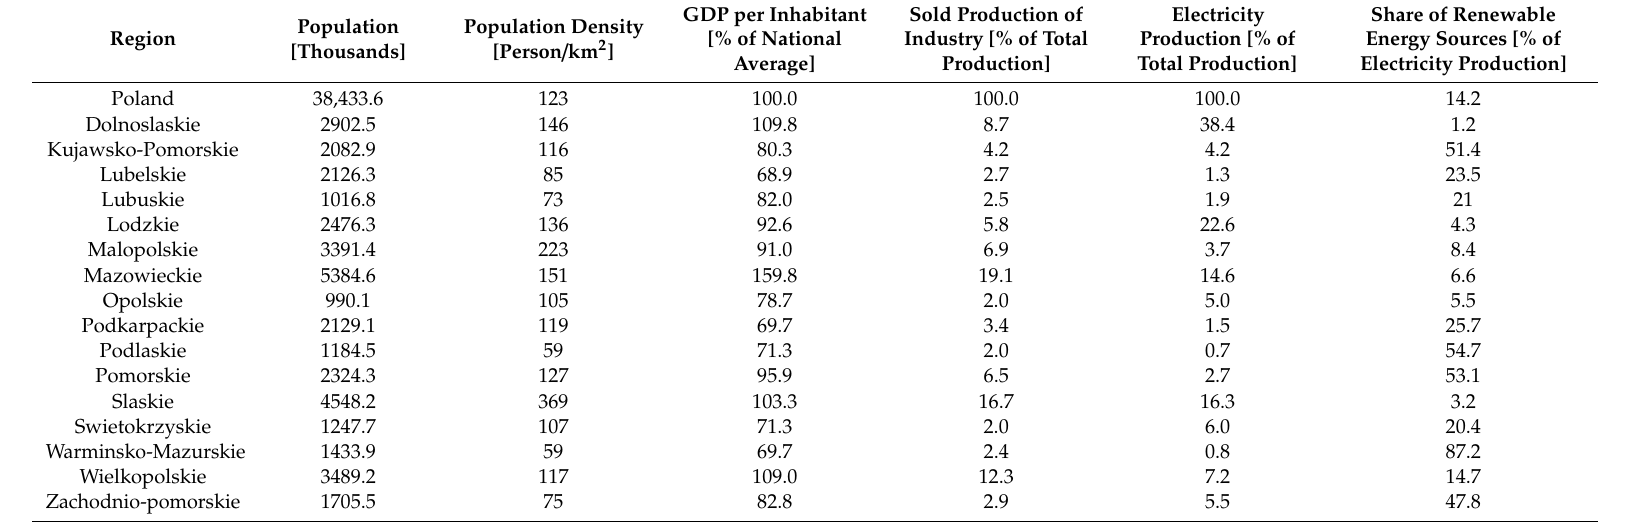
Table 1. Selected indicators for regions of Poland in 2017. Source: Data from